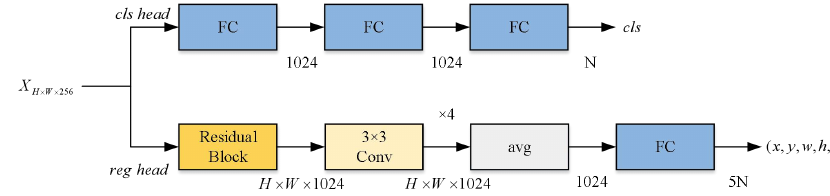
Figure 7. Description of the pairwise branch detection